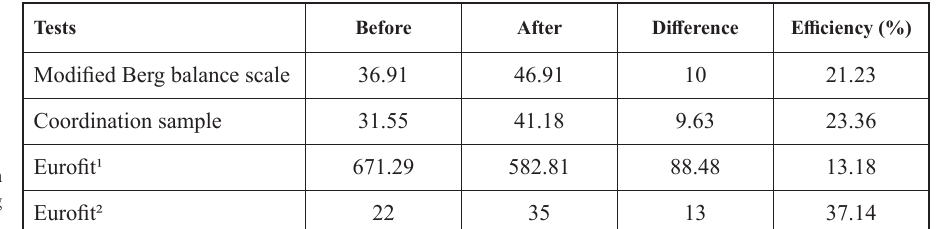
Note. Eurofit¹ – Shuttle run 10 x 5 m.; Eurofit² – Standing Broad